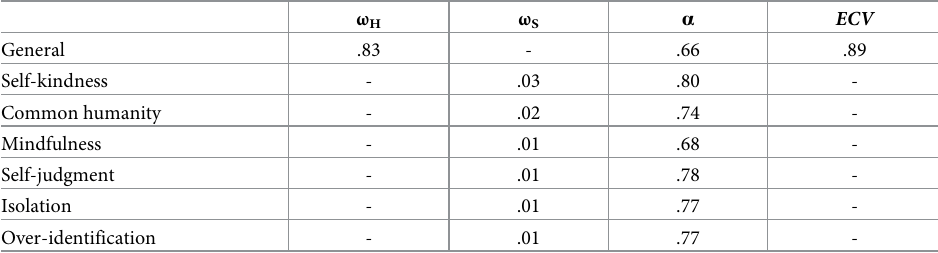
Table 5. Reliability estimates for the